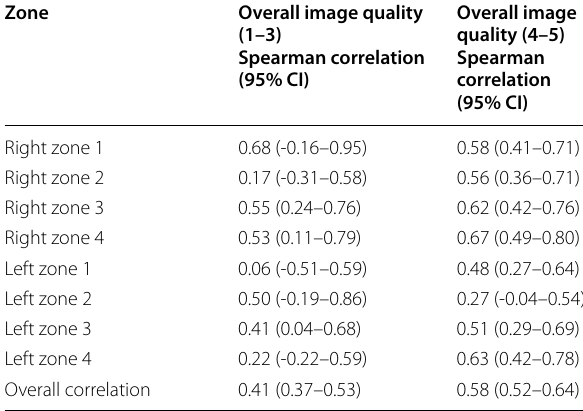
Image quality by zone and overall. Data are based off of 639 images Table 5 ICC between machine AI and expert by image quality, n 611 =